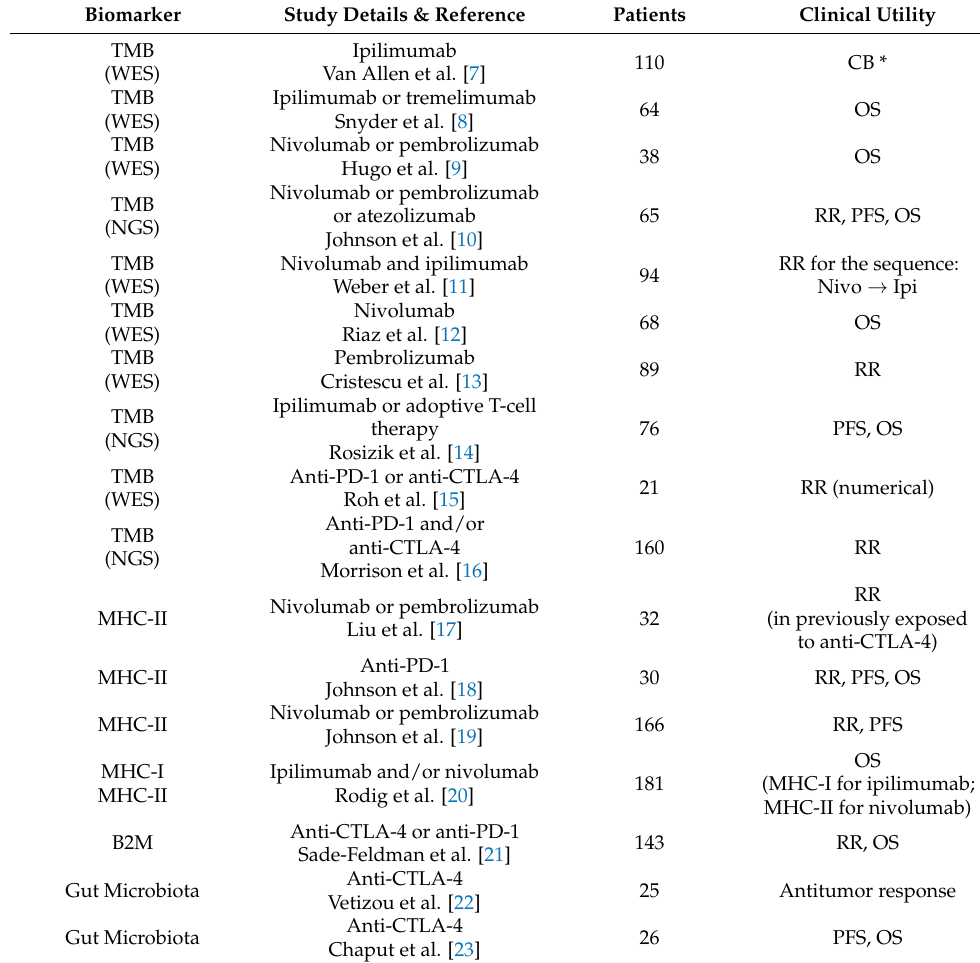
Table 1. List of predictive biomarkers for immunotherapy in melanoma.